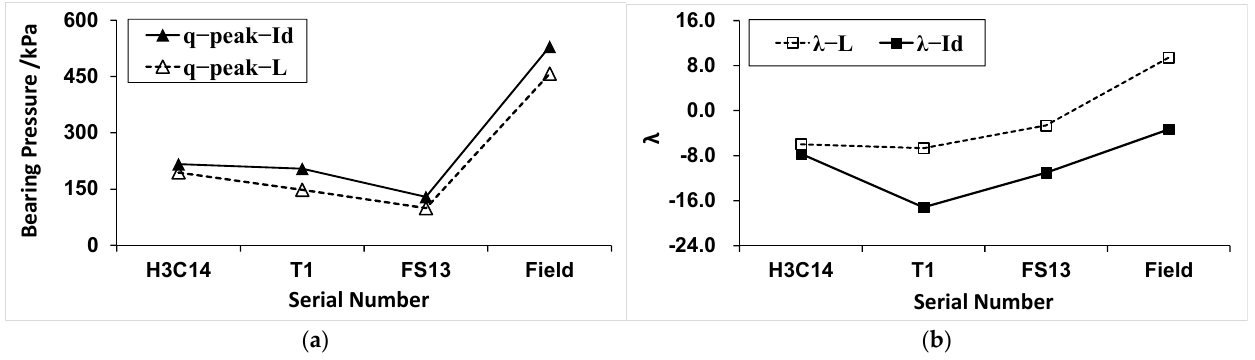
Figure 8. Comparison of peak resistance q peak and degree of post-peak reduction λ : ( a ) peak resistance q peak ; ( b ) degree of post-peak reduction λ